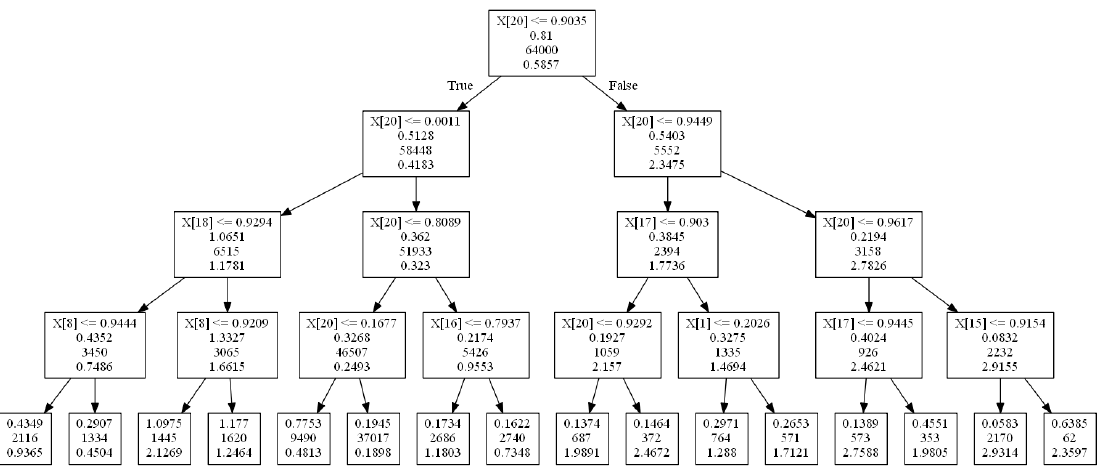
Figure 5. Rules for optimal depth-4 decision